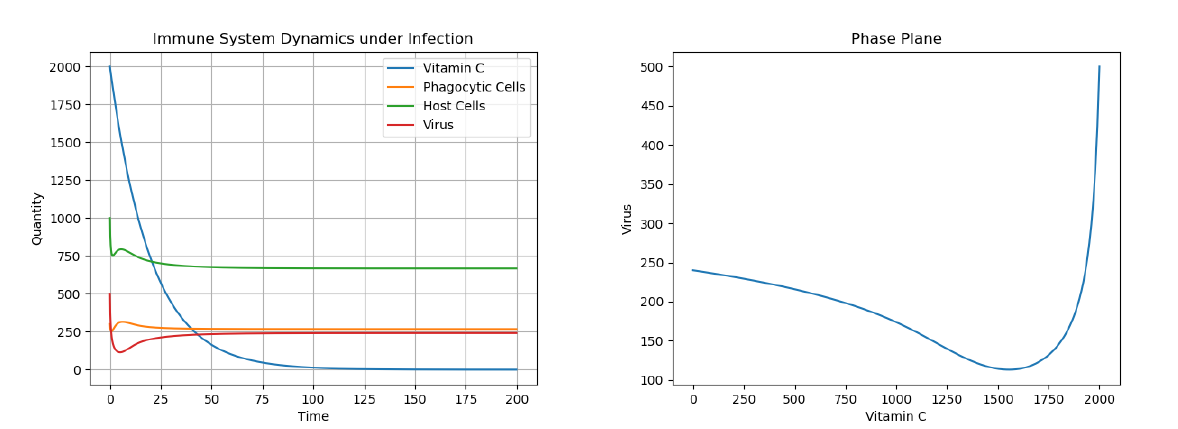
Figure 3. Dynamics under Viral Infection with Single Vitamin C